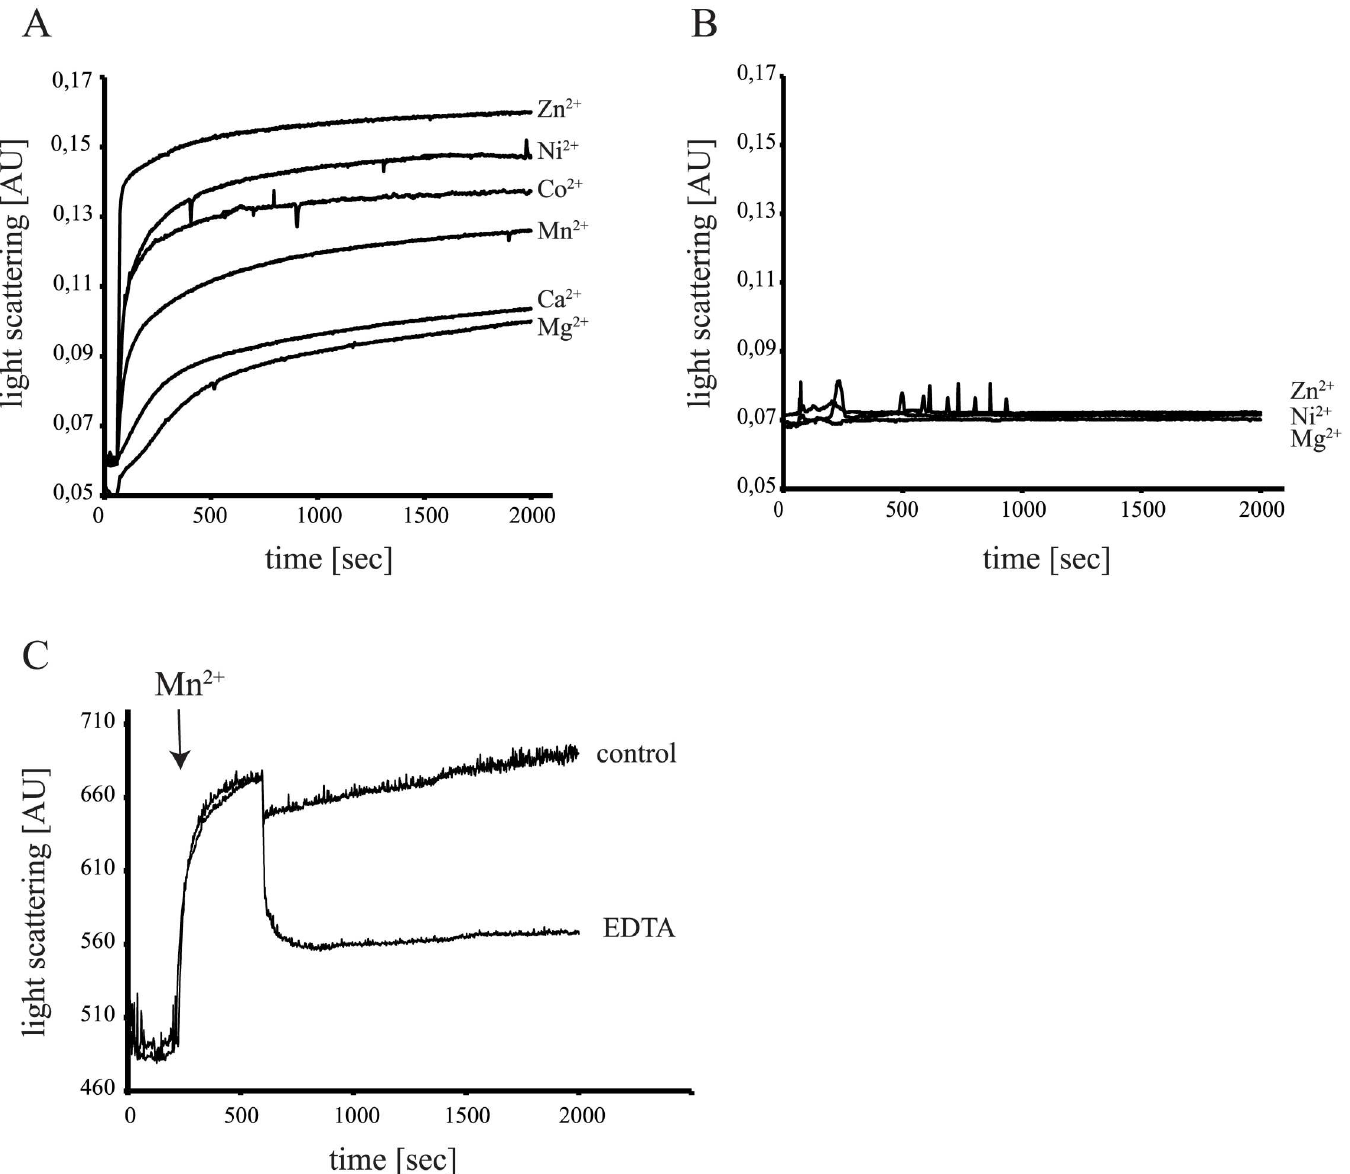
Fig 2. Binding to divalent cations reversibly enhances oligomerization of s-SpoIIE cyt . (A, B) Light scattering measurement of 1,5 μ M s-SpoIIE cyt (A) and MBP (B) in the presenceof 10 mM of divalent cations addedafter 60 sec. (C) Light scattering signal of s-SpoIIE cyt , with 10 mM Mn 2+ added after 60 sec and 20 mM EDTA or H 2 O (control) added after 600